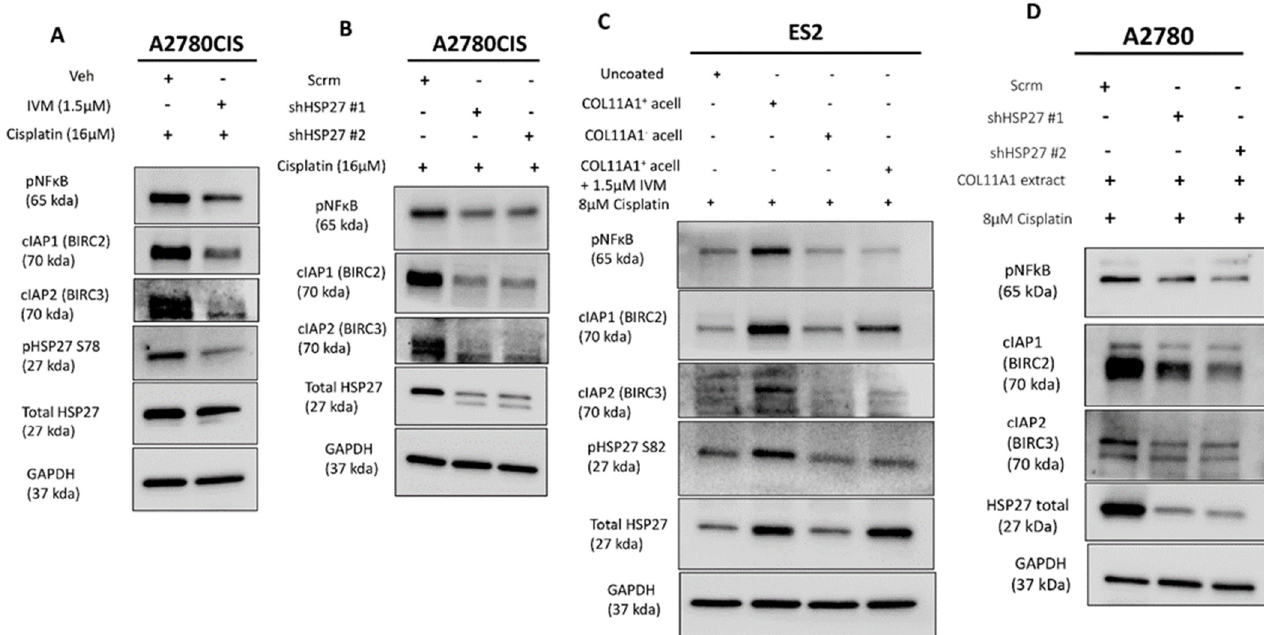
Figure 4. HSP27 regulates NF κ B activity and IAP expression. ( A ) Western blot of the phosphorylated (active) NF κ B, cIAP1 (BIRC2), and cIAP2 (BIRC3) in cisplatin-stimulated A2780CIS cells treated either with the vehicle (Veh) or 1.5 µM ivermectin (IVM) treatments. ( B ) Western blot of the phosphorylated (active) NF κ B, cIAP1 (BIRC2), and cIAP2 (BIRC3) in cisplatin-treated A2780CIS-scrm and A2780CIS-shHSP27 #1 and #2 cells. ( C ) Western blot of phosphorylated (active) NF κ B, cIAP1 (BIRC2), and cIAP2 (BIRC3) in cisplatin-treated ES2 cells cultured in the control, COL11A1-positive a-cellular matrix, COL11A1-negative a-cellular matrix, and COL11A1-positive a-cellular matrix plus the 1.5 µM ivermectin (IVM)-treated conditions. ( D ) Western blot of phosphorylated (active) NF κ B, cIAP1 (BIRC2), and cIAP2 (BIRC3) in cisplatin-treated A2780-scrm and A2780-shHSP27 #1 and #2 cells cultured on COL11A1. GAPDH was used as a loading control for the Western blots. All experiments were performed in the standard experiment conditions (cells cultured in the above conditions for 3 days in 1% FBS medium after overnight serum starvation). The uncropped Western blot figures are presented in Figure S8.